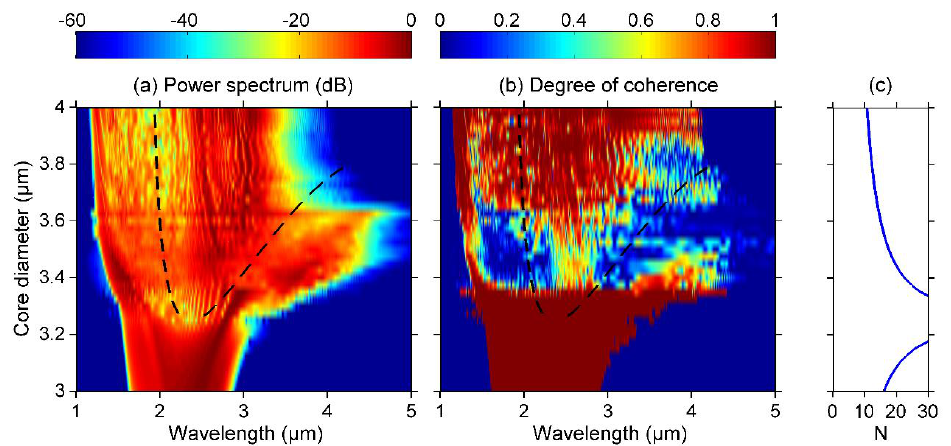
Figure 6. ( a ) Evolution of the average SC spectrum. The fiber length was fixed to 12 cm, and the input peak power of 200-fs pulses at 2300 nm was set to 5 kW (equivalent to 1-nJ pulse energy). ( b ) Corresponding evolution of the modulus of the complex degree of first-order coherence. ( c ) Corresponding soliton number calculated at pump wavelength.